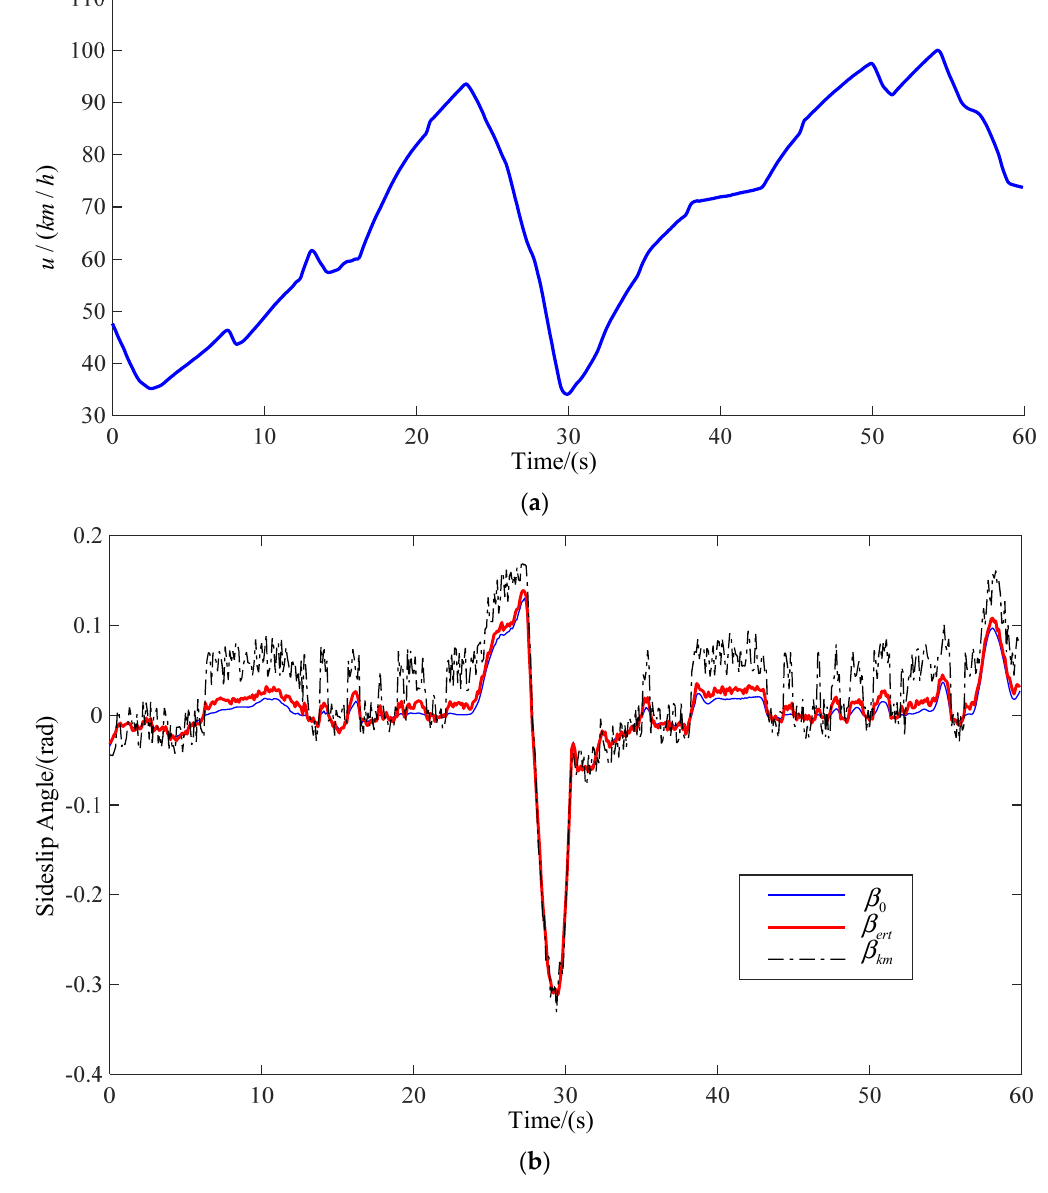
Figure 10. High speed ( a ) real − time speed; ( b ) estimation of sideslip angle.